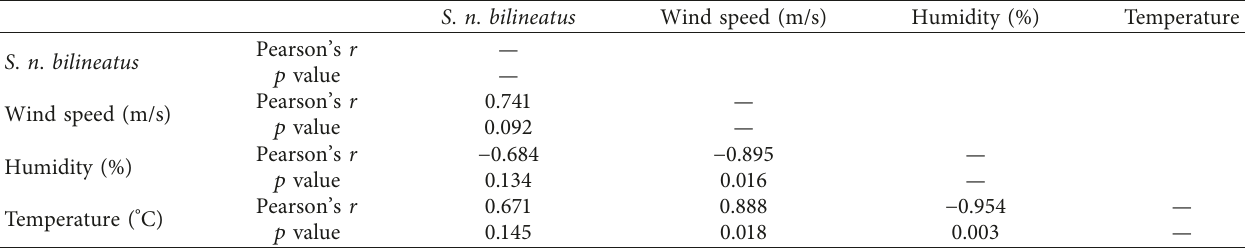
Table 3: Correlation matrix of daily ADT of S . n . bilineatus with weather variables.